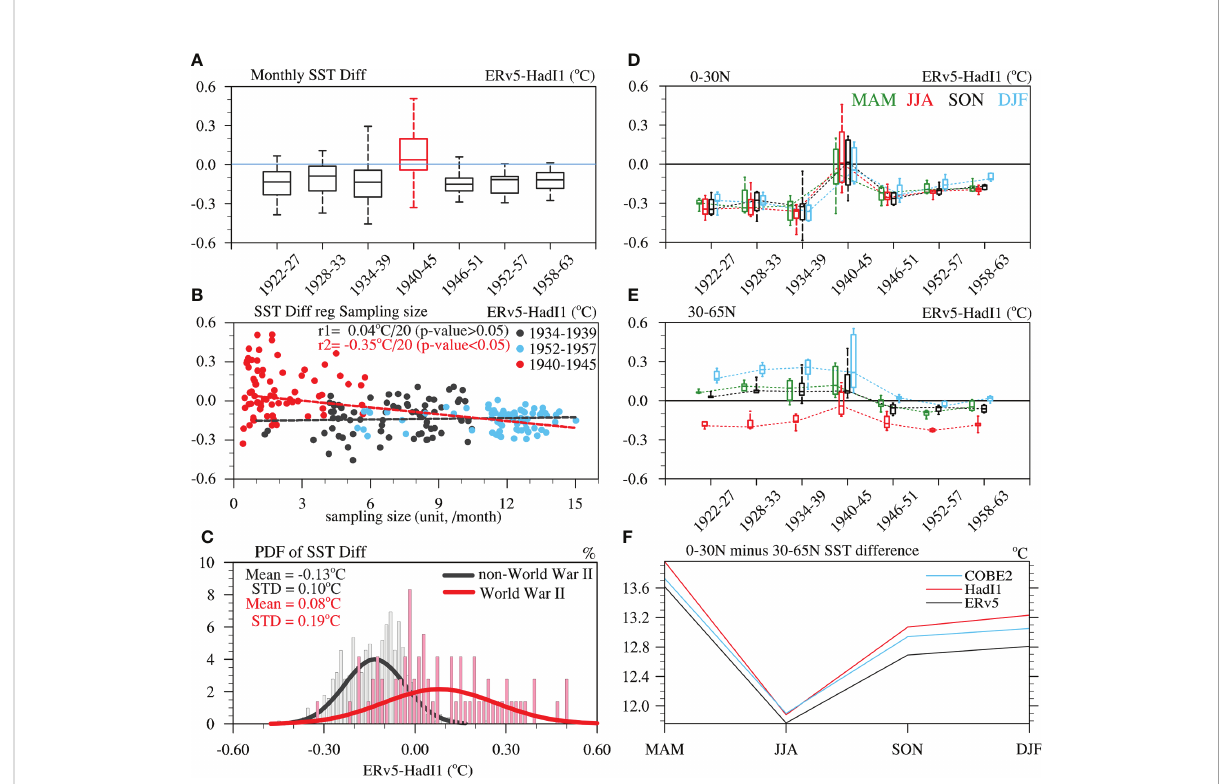
FIGURE 5 Relationship between SST differences (ERv5 minus HadI1) and the period of sampling size over the region of dark blue in Figure 4B during 1922 – 1963. (A) Box plot of monthly SST differences, in which the attributes in a box from top to bottom are the maximum, 75th percentiles, median, 25th percentiles, and minimum, respectively. (B) Sample size against averaged monthly SST differences over the same region as (A) . Fitted values and p -values are also denoted in the fi gure. (C) probability density function (PDF) of randomly resampling the SST differences during the WWII period and non-WWII periods (i.e., pre- and post-war). The average and STD of the SST differences for different periods are given. (D, E) Boxplots of the SST difference (ERv5 minus HadI1) for four seasons over (D) 0° – 30°N and (E) 30° – 65°N. (F) Meridional